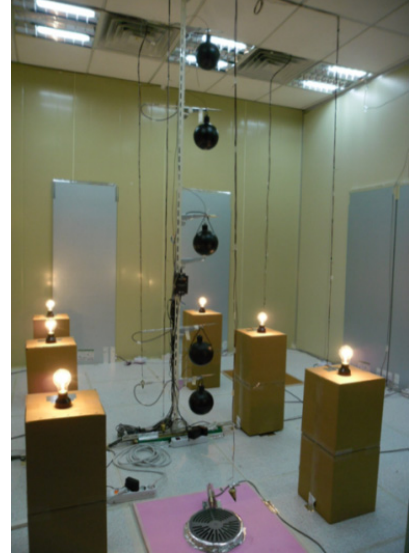
Figure 7. Layout of floor equipment (unit: mm).